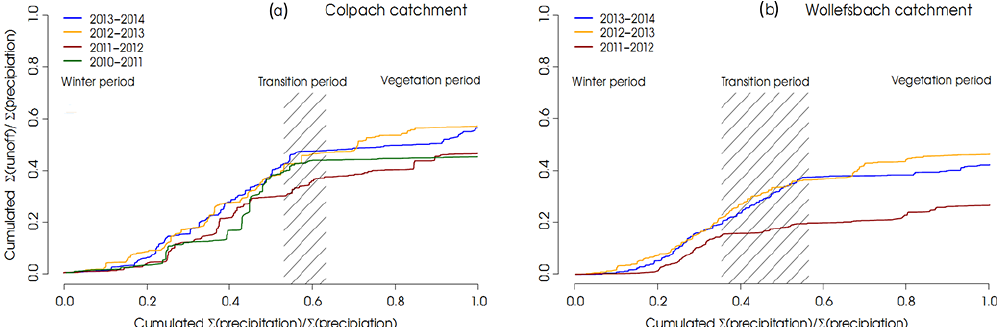
Figure 5. Normalized double mass curves for each hydrological year from 2010 to 2014 in the Colpach catchment (a) and from 2011 to 2014 in the Wollefsbach catchment (b) . The transition period marks the time of the years when the catchment shifts from the winter period to the vegetation period. The separation of the seasons is based on a temperature index model from Menzel et al. (2003). Since the season shift varies between the hydrological years the transition period is displayed as an